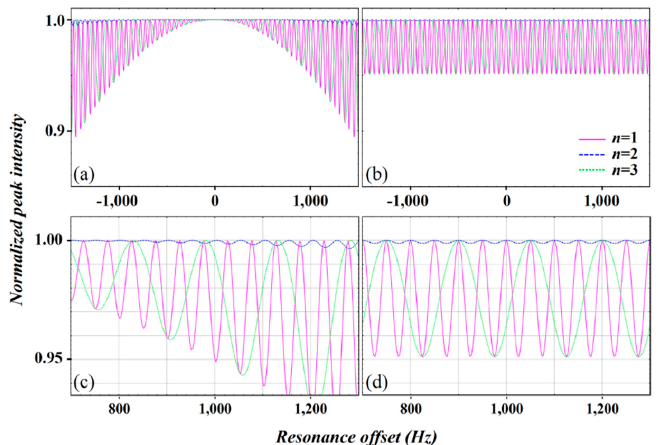
Figure 7. Simulated artifacts occurring in a simple CPMG pulse sequence. A series of n -repeated spin-echoes, { δ – π y – δ } n , were applied within a constant-time period of 20 ms to magnetization S y , which had no J coupling to any other spins. The final intensity of S y is plotted as a function of the resonance offset ranging from − 1500 to 1500 Hz at intervals of 3.0 Hz. ( a ) The refocusing π pulses were applied along the y -axis with a duration of 80 µ s and the exact rf field strength (6250 Hz). Thus, the simulation involved off-resonance effects without pulse miscalibration; ( b ) Refocusing π pulses were applied with the rf field strength reduced by 10% from the exact value, with no off-resonance effects occurring during pulse application. The ν cpmg value equals n /(4 δ ) (solid magenta line: n = 1 ( ν cpmg = 25 Hz), dashed blue line: n = 2 ( ν cpmg = 50 Hz), and dotted green line: n = 3 ( ν cpmg = 75 Hz)). In ( a ), the error maxima were found at frequency offsets that were even multiples of ν cpmg , while in ( b ) they were found at frequency offsets that were odd multiples of ν cpmg . This indicates that errors accumulate in ( a , b ) in the cases where the magnetization vector aligns along the y and x axes, respectively, after δ and just before the first π pulse of phase y . These errors are compensated when the vector returns back to almost the same position along the y and x axes, respectively, after { δ – π y – δ – δ } and experiences the second π pulse of phase y . Such error accumulation and compensation occur alternately after every odd and even numbered spin-echo, respectively. The offset frequencies at which the changes maximize vary depending on the causes of errors. The off-resonance effects and pulse miscalibration generate maximum errors at offset frequencies of even and odd multiples of ν cpmg , respectively. Parts of ( a , b ) are enlarged and shown in ( c , d ), respectively. The corresponding vector models are depicted in Figure